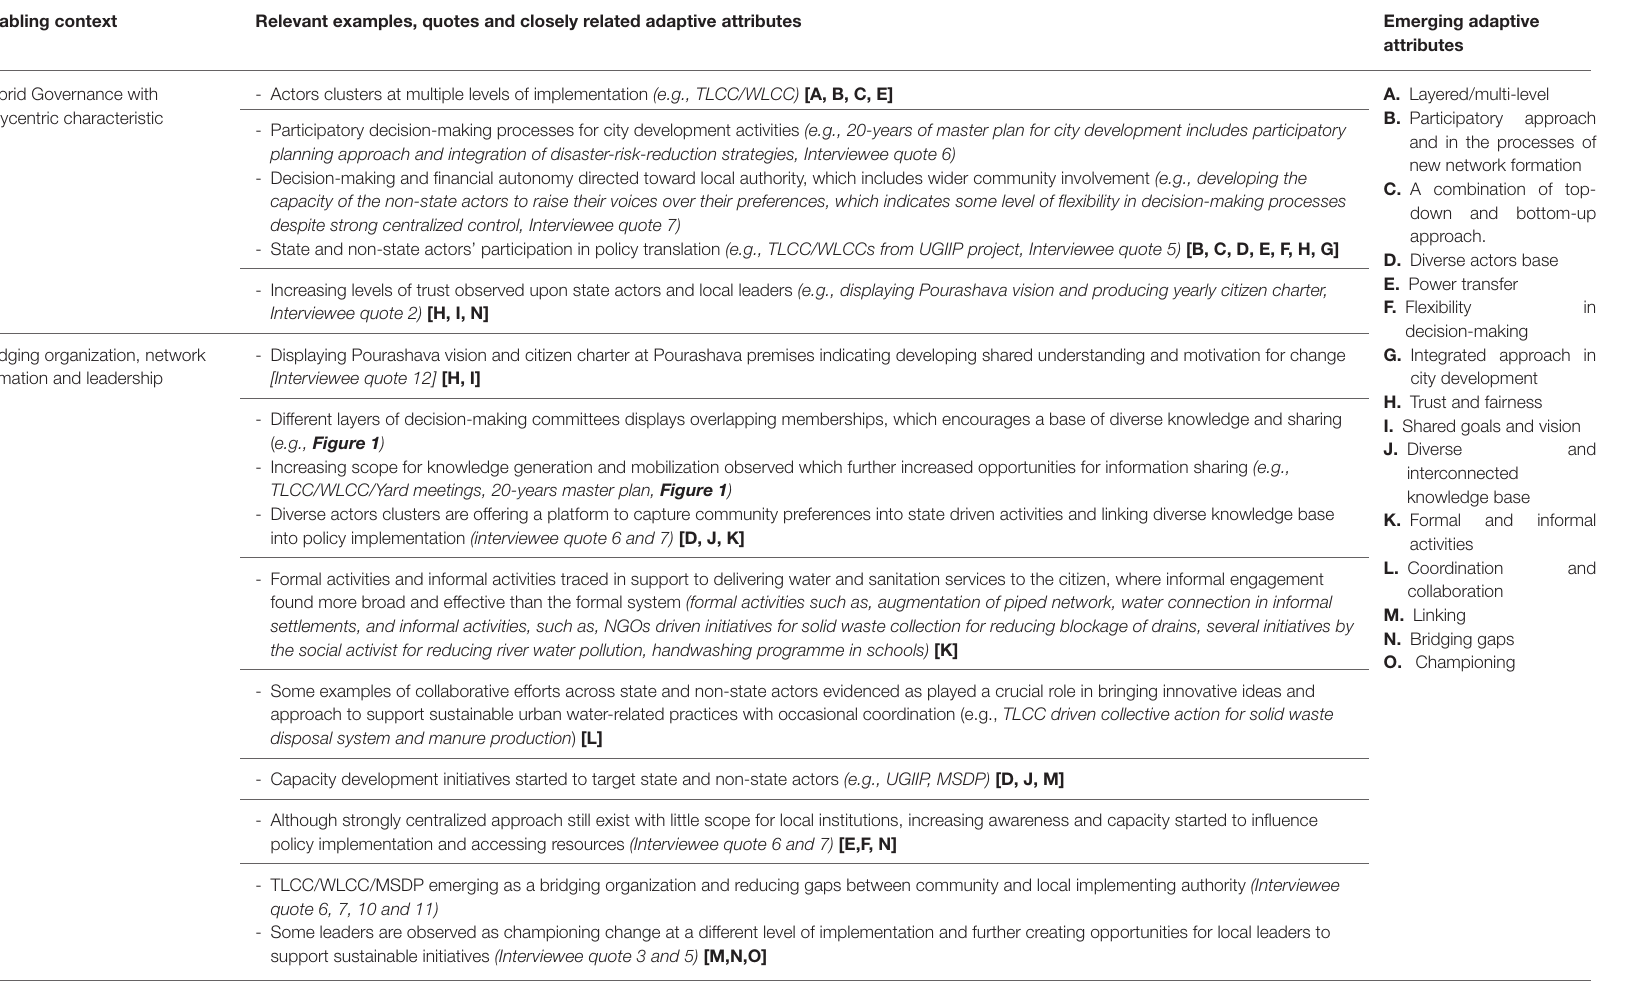
TABLE 4 | Enablers and emerging adaptive attributes identified in the ACA framework in Mymensingh urban water governance. Mymensingh urban water